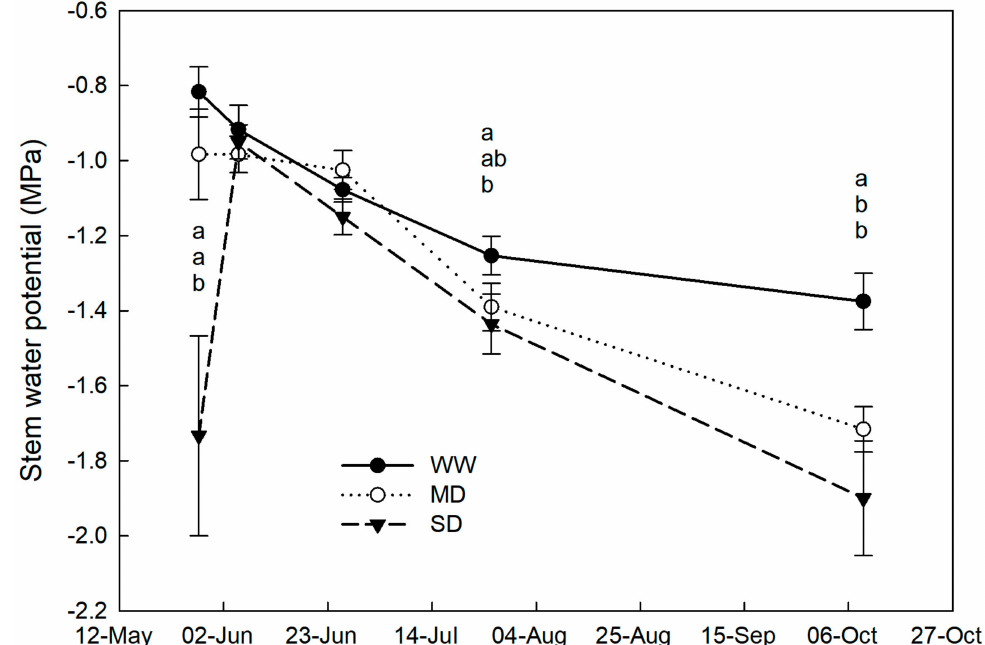
Figure 1. Stem water potential in loquat plants under well-watered conditions (WW), mild-drought (MD), and severe drought (SD) during the four months of the trial. Error bars represent standard errors of means. When present, di ff erent letters indicate significant di ff erences among drought treatments for a specific date (Tukey’s multiple range test, p <